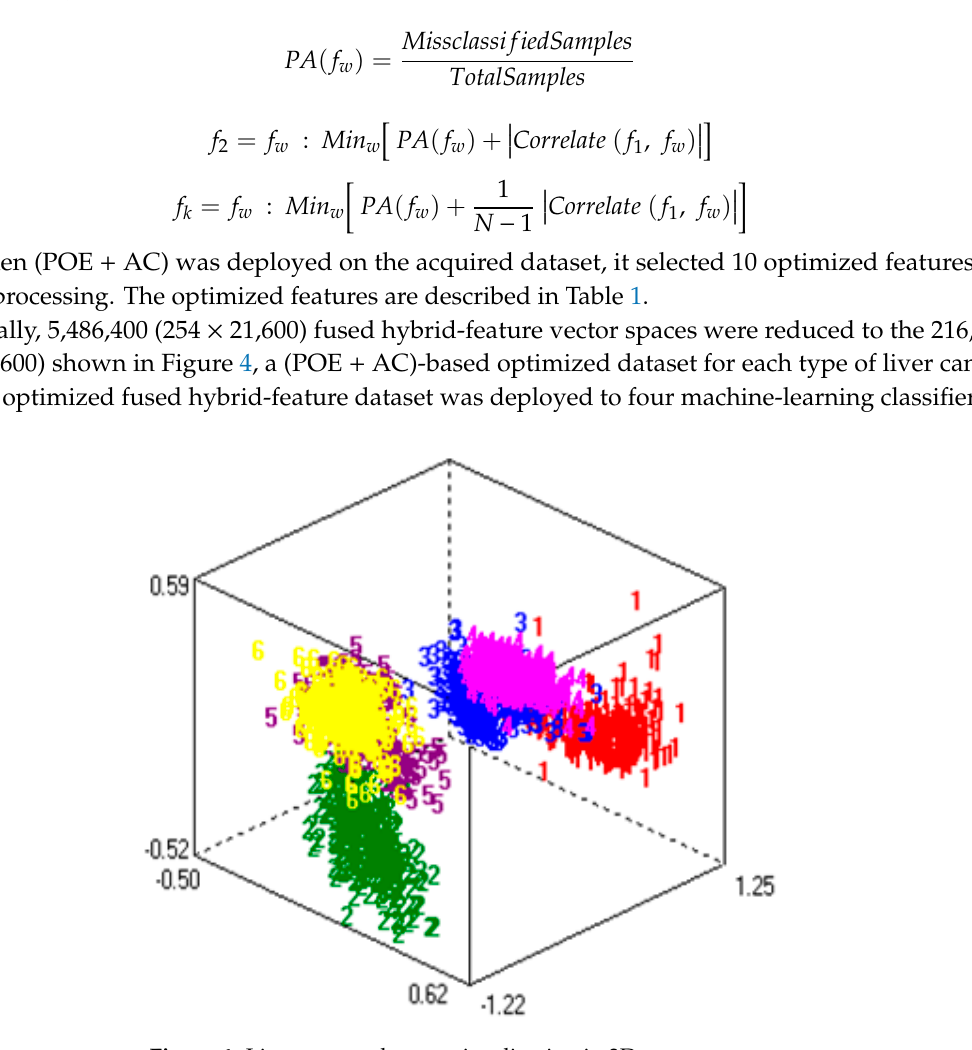
Figure 4. Liver cancer dataset visualization in 3D vector space.